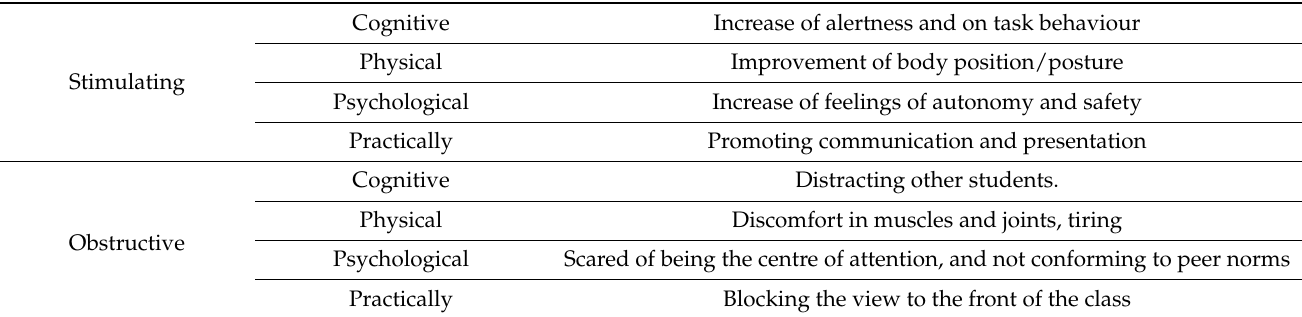
Table 2. Summary of the results for theme 2: What are reasons to use or not use the desk in a standing position? Cognitive Increase of alertness and on task behaviour Physical Improvement of body position/posture Stimulating Psychological Increase of feelings of autonomy and safety Practically Promoting communication and presentation Cognitive Distracting other students. Physical Discomfort in muscles and joints, tiring Obstructive Psychological